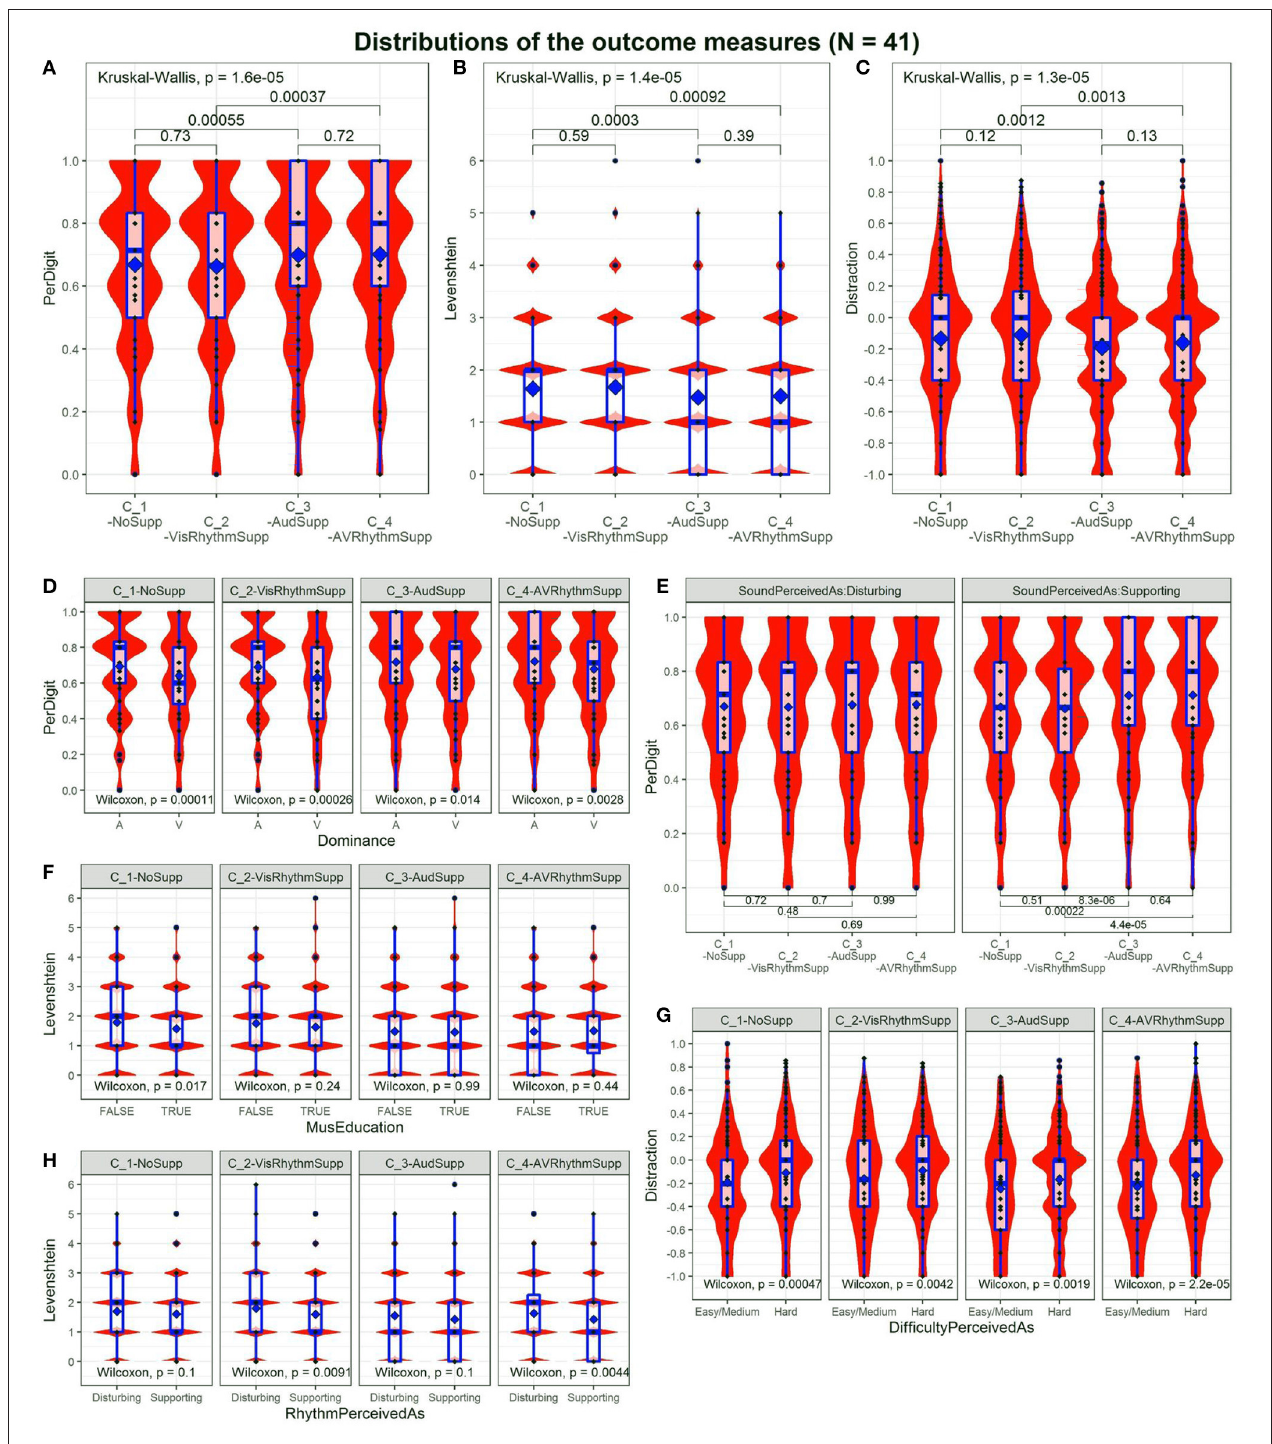
FIGURE 3 | Distributions for the different outcome scores across conditions. Significance p -values between conditions are indicated. (A) “PerDigit” score. (B) “Levenshtein” score. (C) Distraction score. The bump at –0.4 is due to the way scores are calculated. (D) Influence of audiovisual Dominance on task performance across conditions. (E) Influence of SoundSupport (Disturbing vs. Supporting) on task performance. (F) Influence of MusEducation on task performance across conditions. (G) Influence of TaskDifficulty (Easy/Medium vs. Hard) on task performance across conditions. (H) Influence of RhythmSupport (Disturbing vs. Supporting) on task performance across